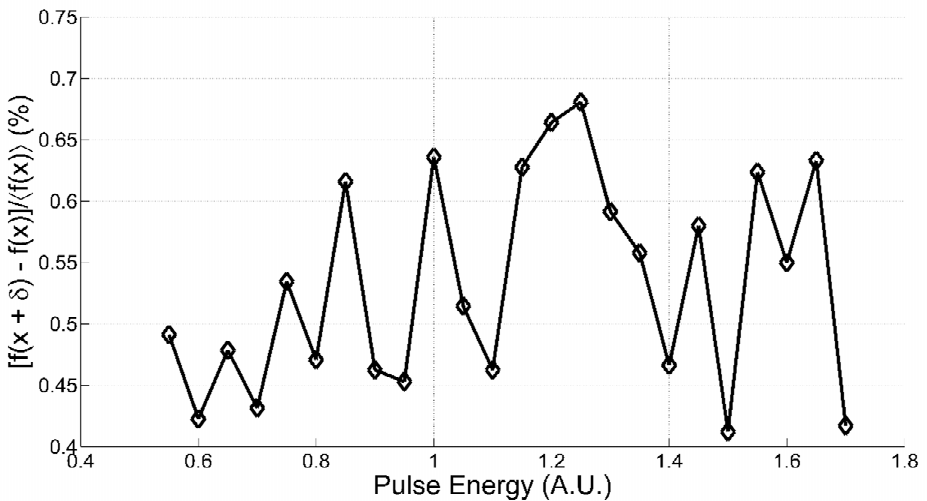
Figure A5. The finite-di ff erence response curve as function of the variable LED supply voltage (anode to cathode voltage levels of the PMT at 900